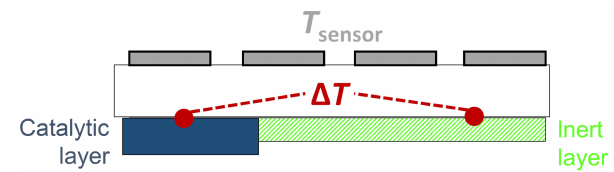
Figure 1. Cross section of the sensor device. The temperature dif- ference (cid:49)T is measured by a screen-printed thermopile structure. The activity of the catalytic layer is controlled by the overall sensor temperature ( T sensor ), which is provided by an integrated heating element (schematically